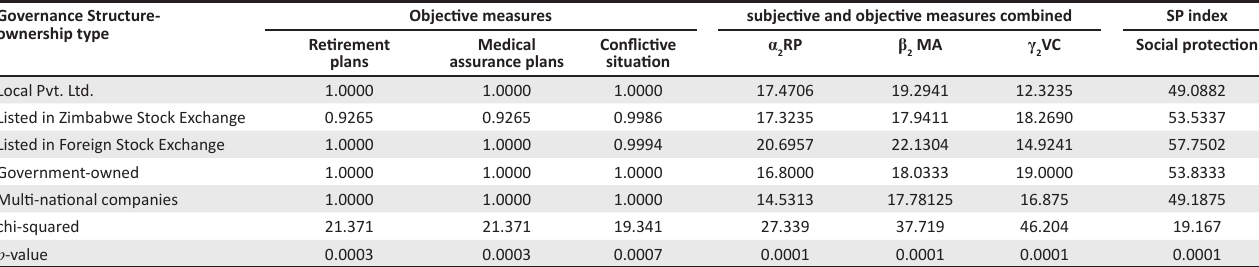
TABLE 5: Social protection. Governance Structure- ownership type